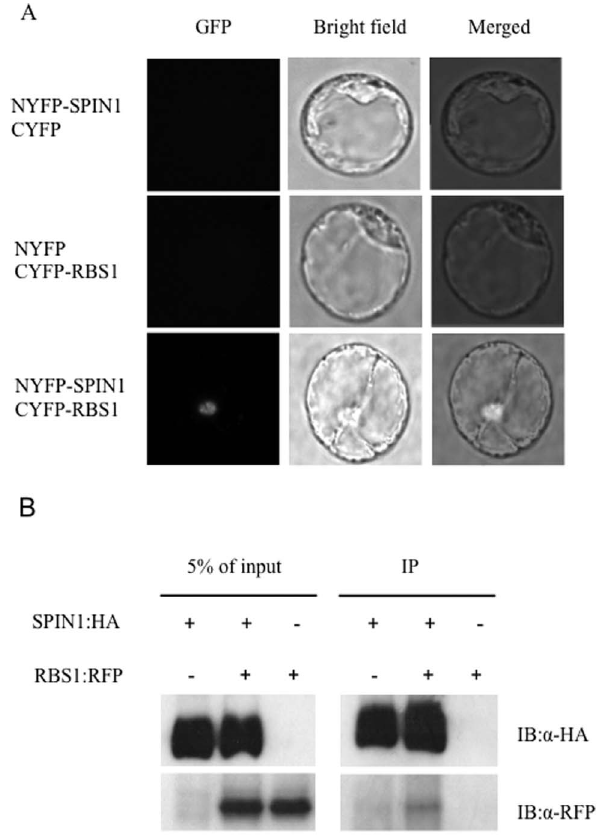
Figure 3. Interaction between SPIN1 and RBS1 inplanta . (A) BiFC detection of the SPIN1–RBS1 interaction in rice protoplasts. (B) Co-IP of RBS1:RFP with SPIN1:HA in N. benthamiana.